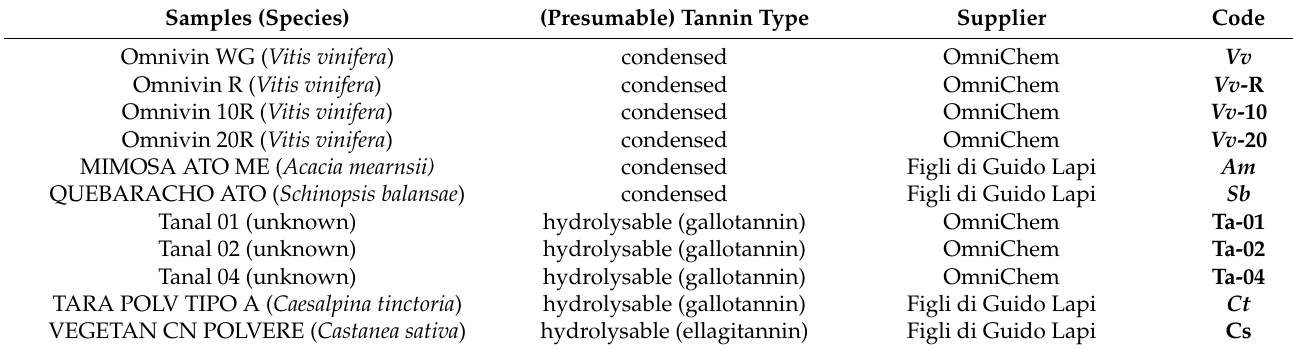
Table 1. Commercially available tannins used for a detailed structural